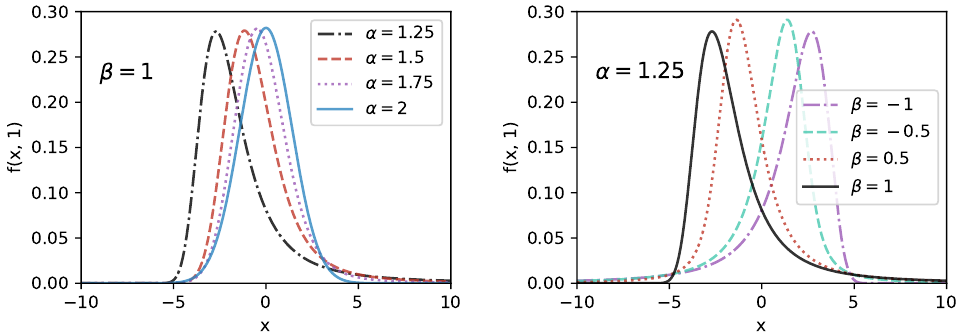
Figure 2. Probability density function of Lévy flights with K α = 1 at time t = 1. The value α = 2 is the Gaussian limit, so that β become irrelevant and the PDF is